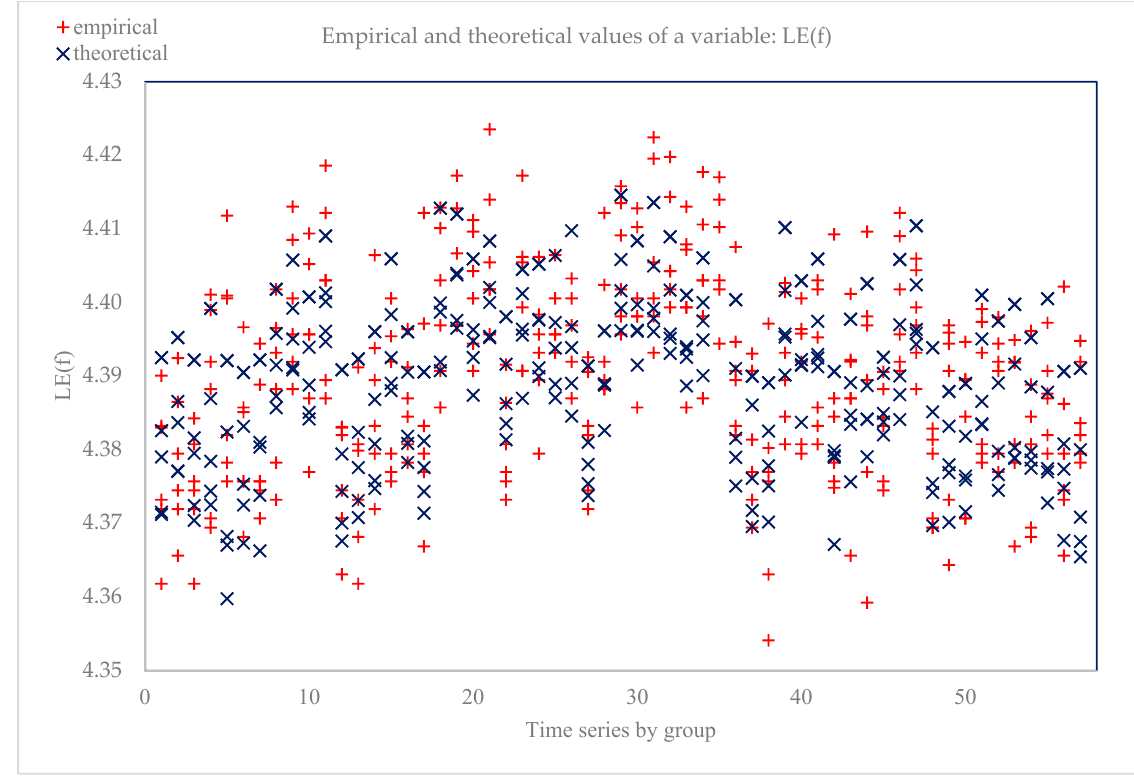
Figure 2. Empirical and aligned variable values (dependent variable LE(f) = 0).